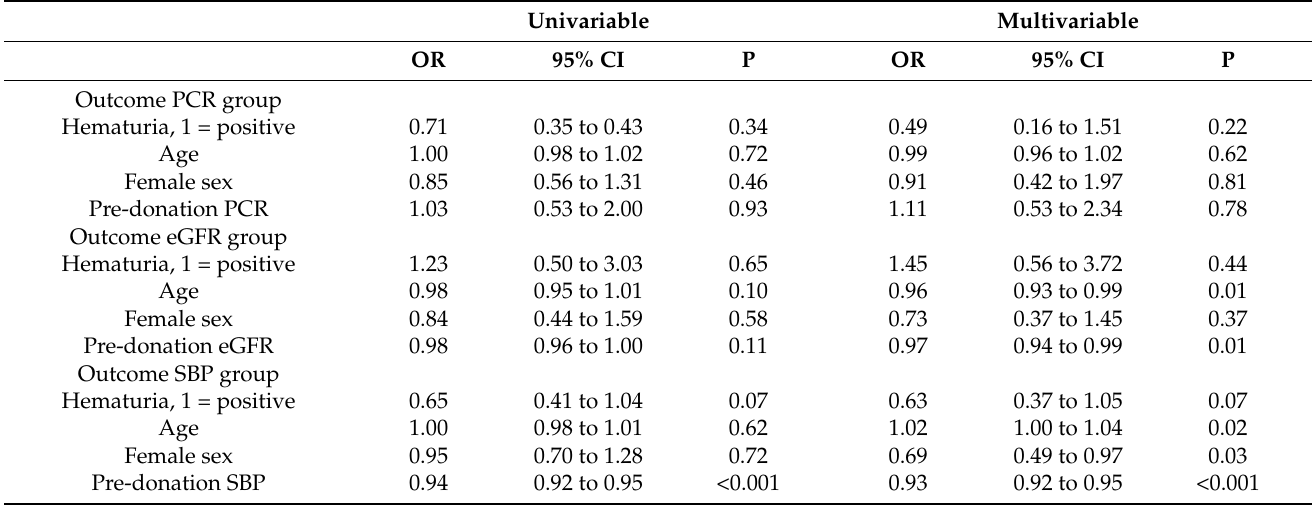
Table 5. Uni- and multivariable logistic regression analyses of pre-donation hematuria and worse post-donation